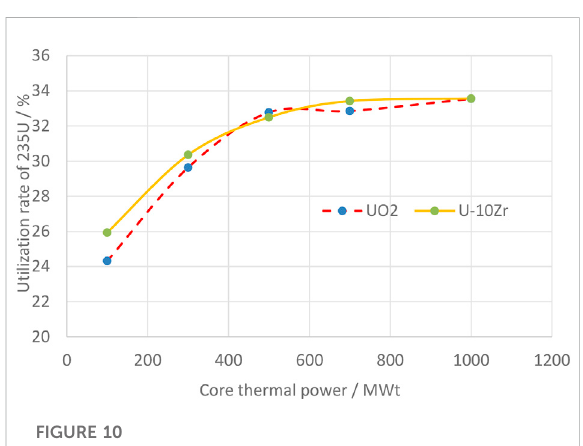
FIGURE 11 Utilization rate of 238U along with the core power